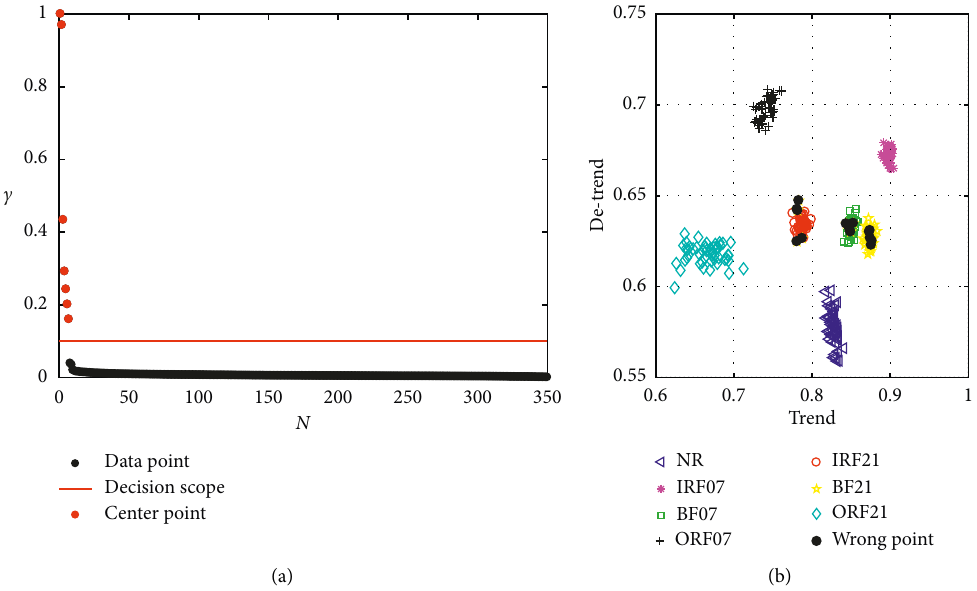
Figure 10: The clustering result of the rolling bearing by using the SPA-DE-DPC: (a) decision graph and (b) clustering result.